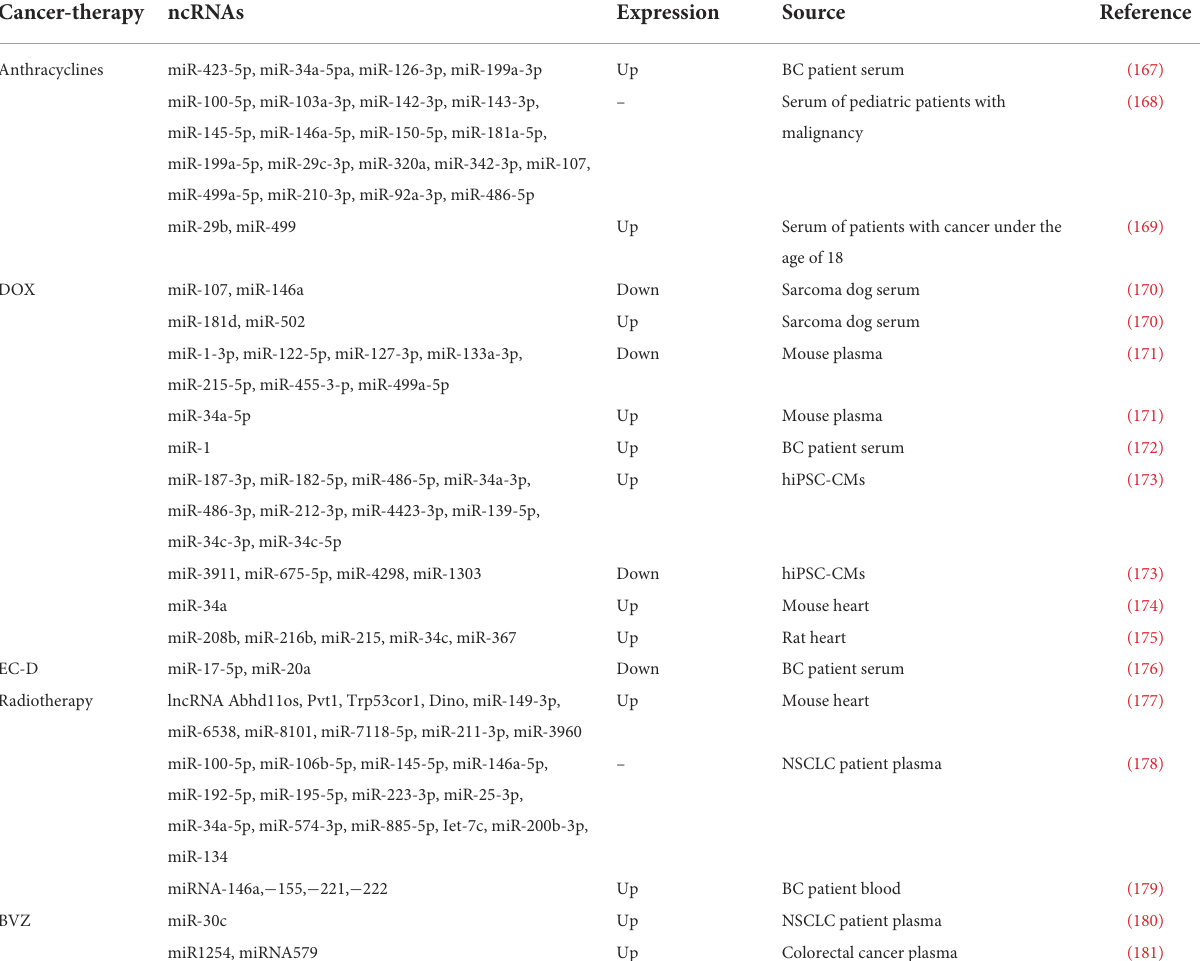
TABLE 2 ncRNAs as biomarkers in cancer therapy-induced cardiotoxicity. Cancer-therapy ncRNAs